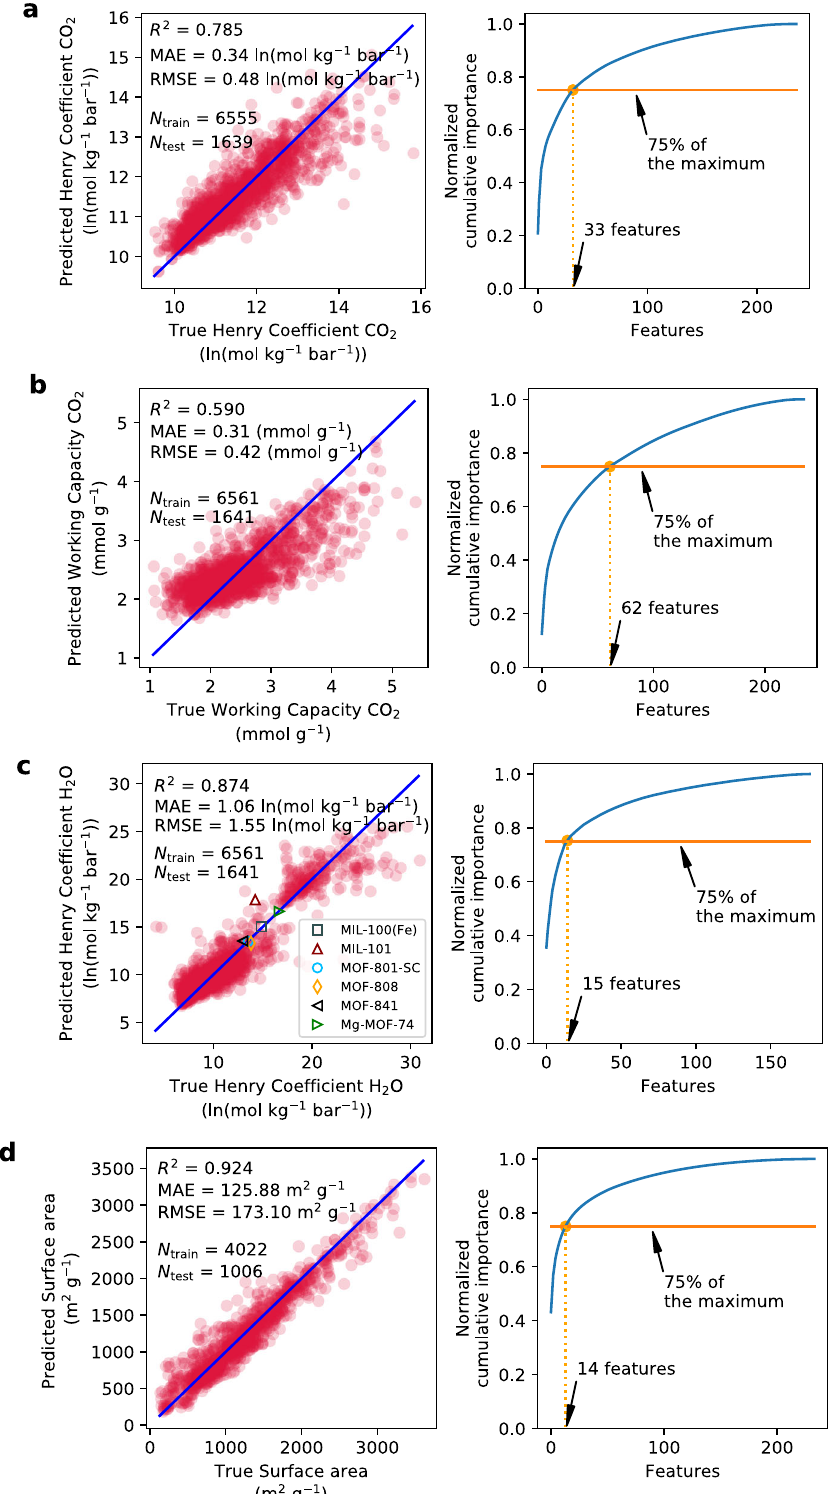
Fig. 2 Predictions and corresponding normalized cumulative curves for the coef fi cients of importance of the four Random-forest regression models. Results are reported for a Henry coef fi cient for CO 2 , b working capacity for CO 2 , c Henry coef fi cient for H 2 O (with experimental values for MIL-100(Fe) 81,82 , MIL-101 81,83 , MOF-801-SC 68 , MOF-808 68 , MOF-841 68 , Mg-MOF-74 84,85 ), d surface area; model performances are shown in terms of coef fi cient of determination R 2 , mean absolute error (MAE), and root mean squared error (RMSE), with the size of training and testing sets N train and N test ,